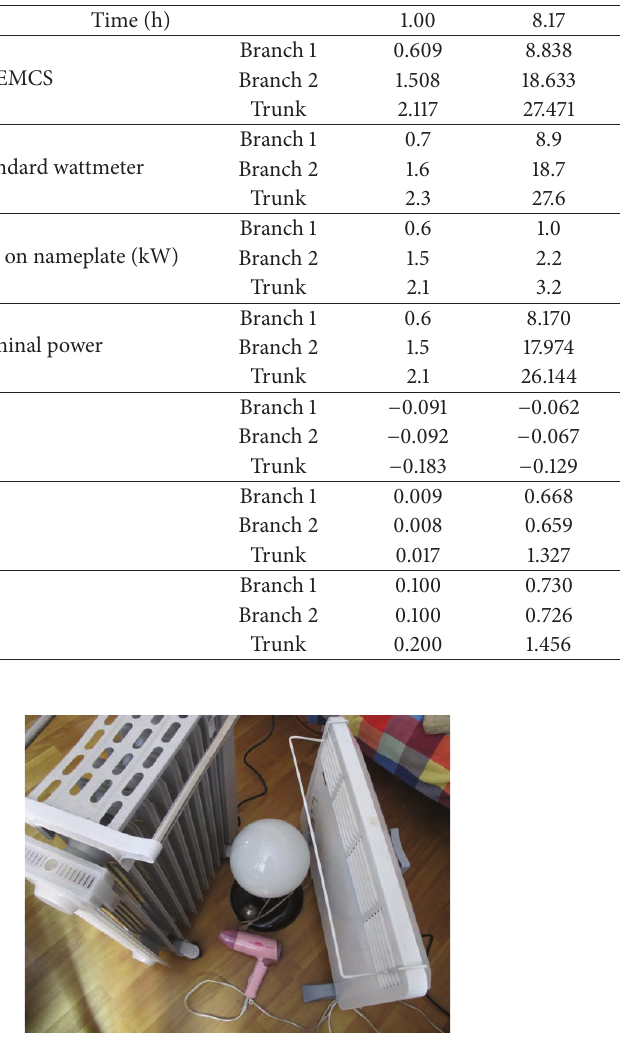
Figure 13: The tested appliances included a lamp, a hair dryer, and two electric heaters.